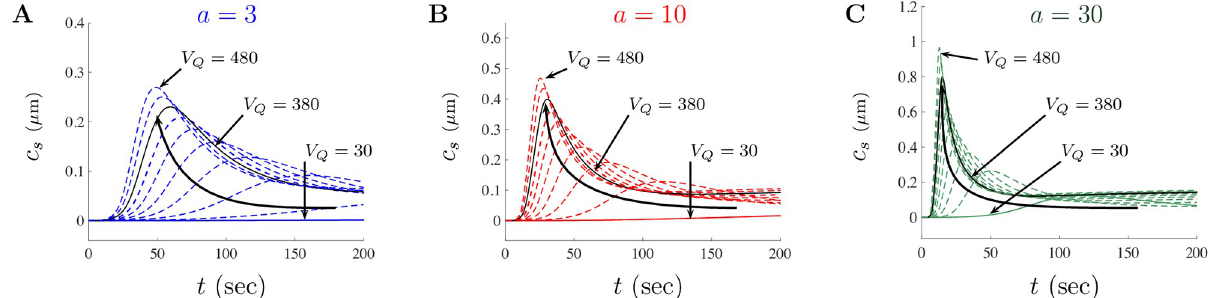
Fig 10. PRCC prediction on solution amplitude and time to peak for model parameter V a = 10, and a = 30 in A , B , and C , respectively. In each diagram, the curved black arrow tracks the shift in the peak of solutions as V Q takes on various values ranging from V = 30 to V = 480. The black trace in each diagram represents the baseline V Q Q